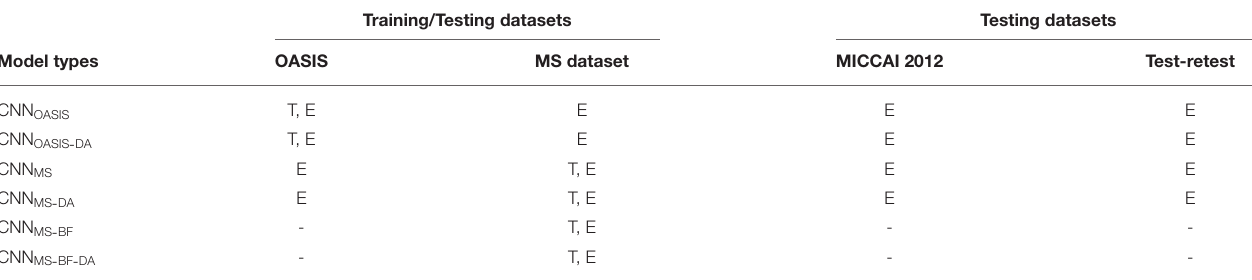
TABLE 1 | Summary of the trained